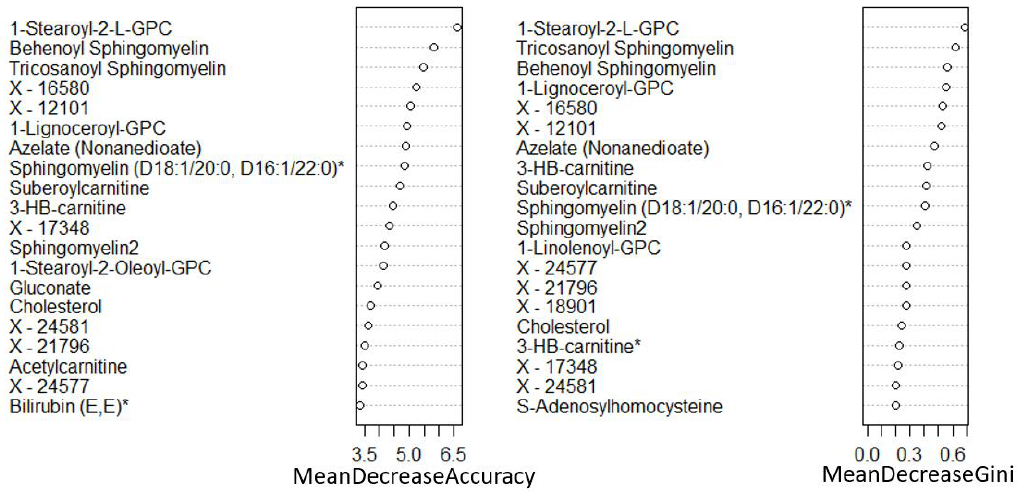
Figure 17. Top 20 discriminatory metabolites for the detection of endometrial cancer in post-menopausal women ( n = 77, cases = 56, controls = 21). Metabolites were identified by random forest machine learning and ranked by their contribution to classification accuracy using mean decrease accuracy metric and mean decrease gini index. Metabolites starting with X are unnamed; the pathways of these are unknown.